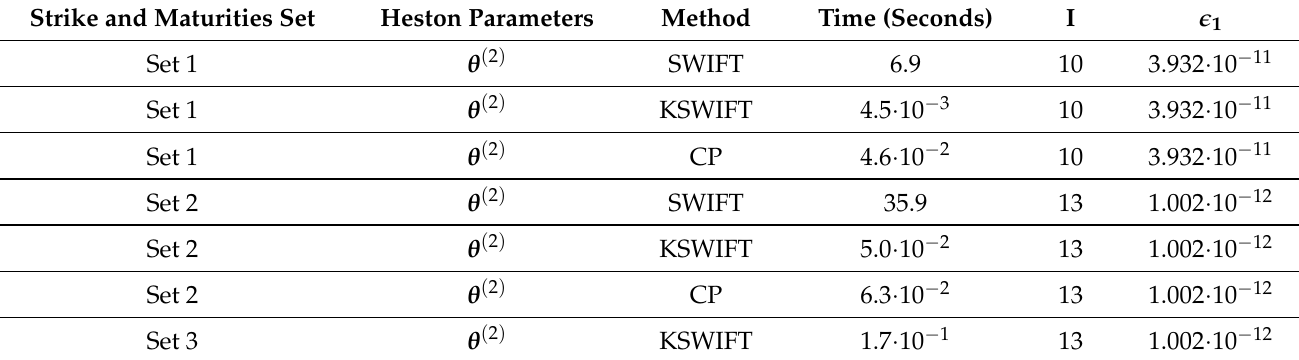
Table 4. Iterations, time needed to calibrate each speed scenario and objective function value reached. I refers to the number of iterations that LM requieres until it stops, and (cid:101) 1 corresponds to the LM first stopping criteria (see Section 4), which refers to the objective function final